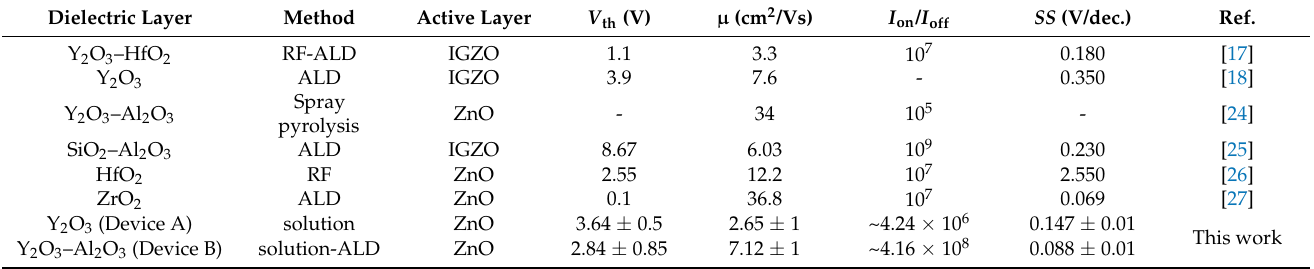
Figure 4. ( a ) Capacitance–frequency curve per unit area of Y 2 O 3 film and Y 2 O 3 –Al 2 O 3 film ( b ) Leakage characteristic curve of Y 2 O 3 film and Y 2 O 3 –Al 2 O 3 film. Table 1. Electrical properties of device A, B and compare with other TFTs.